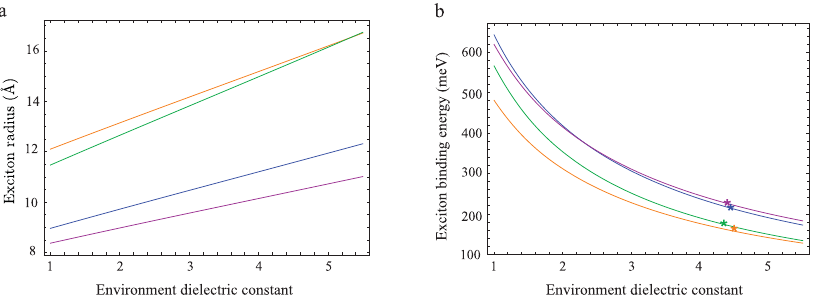
Fig. 2 Dependence of exciton characteristics on the dielectric environment. a Variation of the exciton radius and b of the binding energy with the surroundings average dielectric constant. The orange lines are for ML WSe 2 ( μ r = 0.2 m 0 , r 0 = 45 Å ), green lines — for ML WS 2 ( μ r